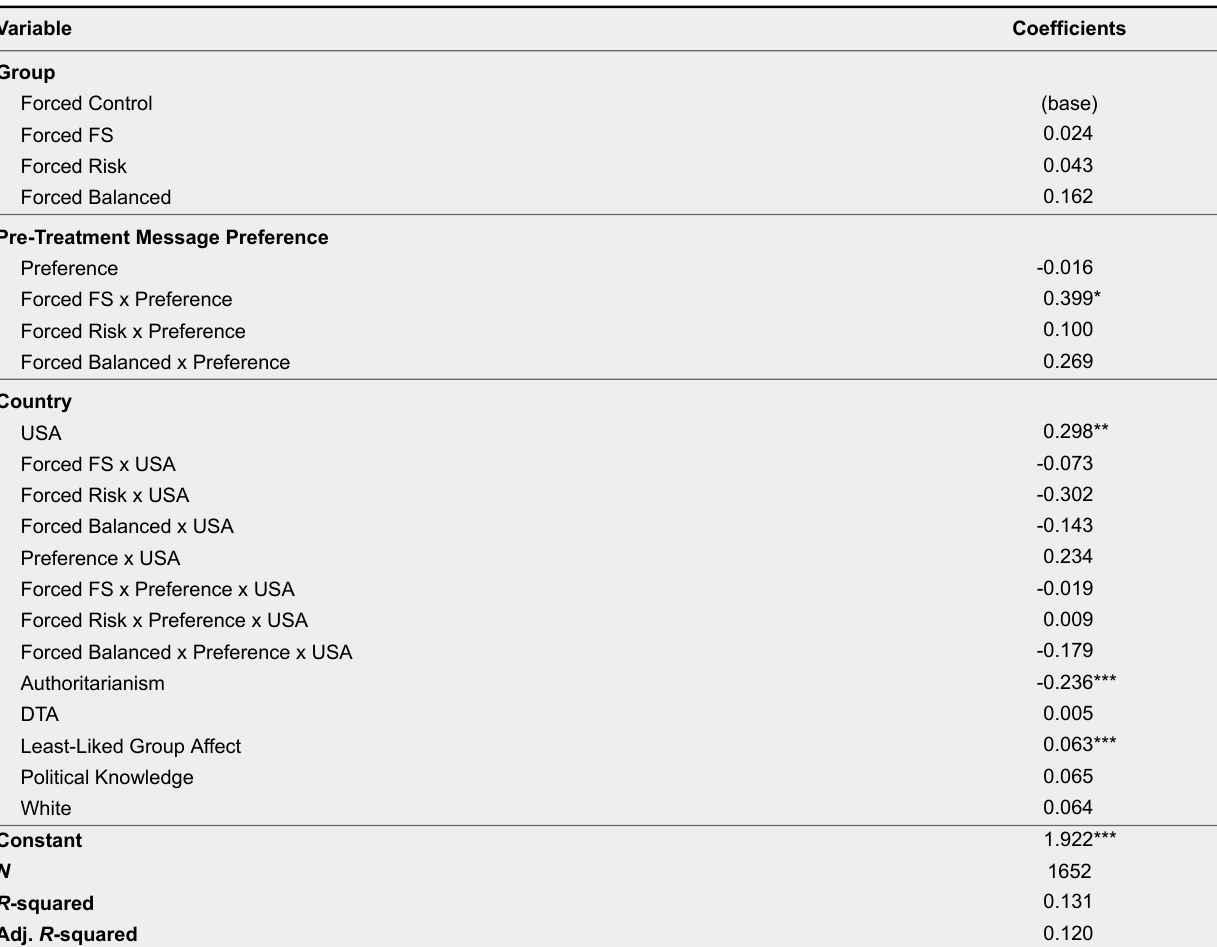
Conditional Effects of Political Messages on Political Tolerance: Forced Exposure